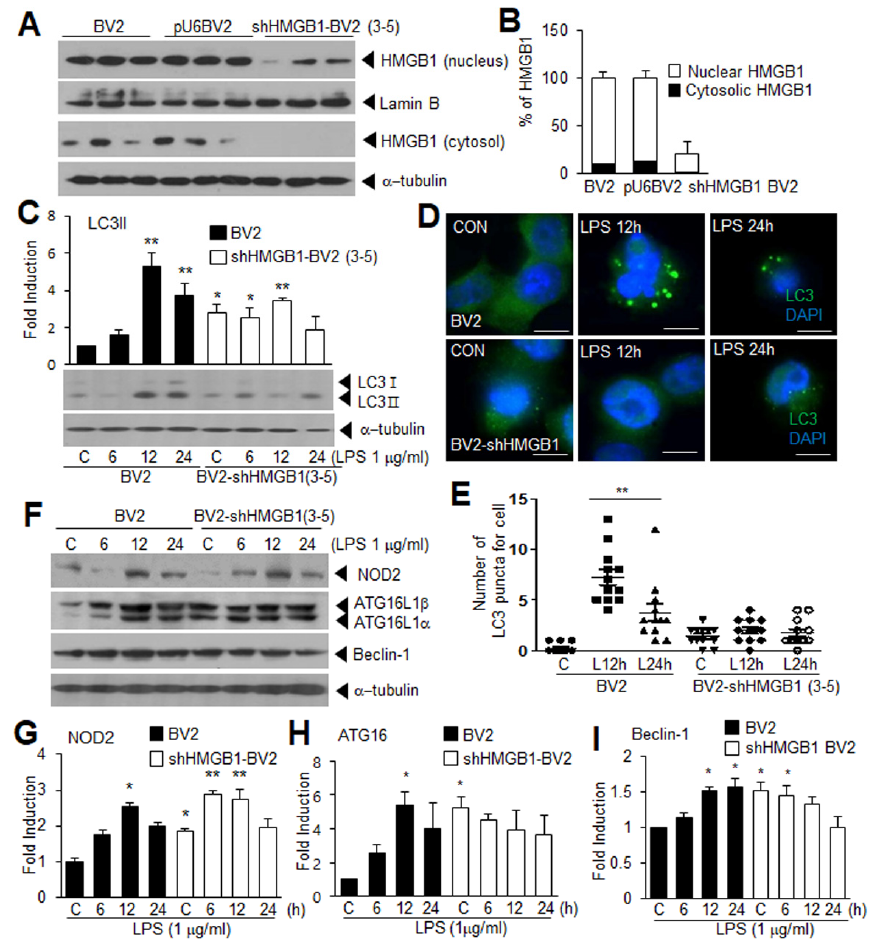
Figure 4. LPS-induced autophagy is significantly suppressed in HMGB1 KD BV2 cells. BV2 cells were transfected with pU6 plasmid expressing HMGB1 shRNA (shHMGB1-BV2) or empty pU6 plasmid (pU6-BV2), and shHMGB1-BV2 (3-5) cell line was selected. ( A , B ) Nuclear and cytosolic HMGB1 levels were examined using immunoblot analysis in wild type, pU6-BV2, and shHMGB1-BV2 cells, and representative immunoblot and quantification results are presented ( n = 3); ( C , F – I ) Wild-type BV2, pU6-BV2, and shHMGB1-BV2 cells were treated with LPS (1 µ g/mL) for 6, 12, and 24 h, and the levels of LC3 ( C ), and NOD2, ATG16, and Beclin-1 ( F – I ) were examined using immunoblotting analysis. Representative immunoblots are presented in ( C ) and ( F ), and quantification results are presented as the mean ± SEM ( n = 4) in ( C ) and ( G – I ); ( D , E ) Wild-type BV2, pU6-BV2, and shHMGB1-BV2 cells were treated with LPS (1 µ g/mL) for 12 and 24 h, and immunofluorescence staining was performed with anti-LC3 antibody (green) and DAPI (blue). Representative images are shown in ( D ), and quantification of the dot- or ring-shaped LC3 signals (representing autophagosomes) are presented as the mean ± SEM ( n = 12) in ( E ). Scale bar, 20 µ m. * p < 0.05, ** p < 0.01 vs. PBS-treated control